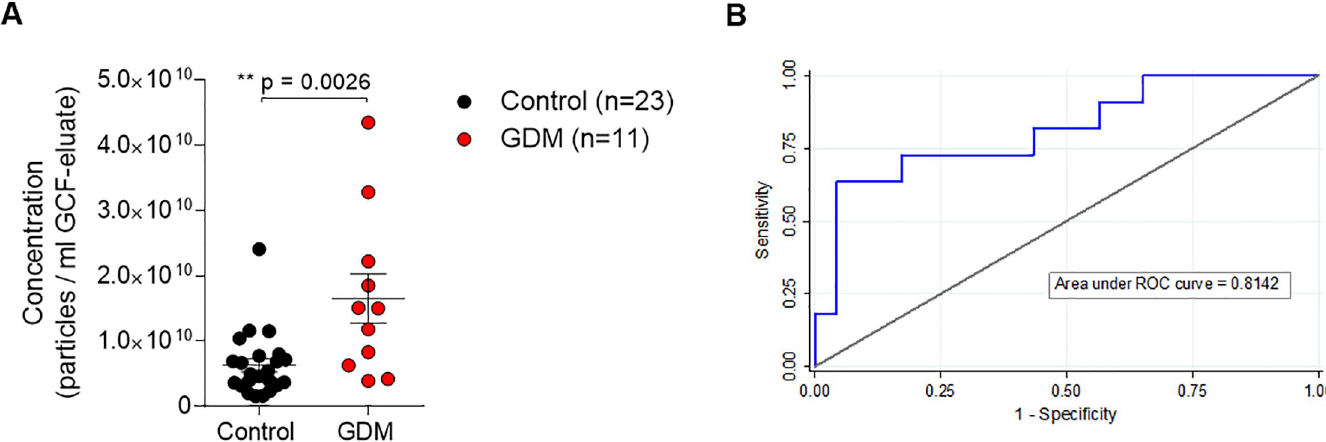
Fig 3. Concentration of EVs isolated from GCF in Controls and GDM patients. A. Mean concentration of total extracellular vesicles present in GCF eluate from Controls (n = 23) and GDM (n = 11). Results are the mean ± SEM. ��� p � 0.001. GDM, gestational diabetes mellitus. B. Receiver Operating Characteristic curve for the prediction of GDM by log 10 EVs concentration in the first trimester (AUC = 0.814). AUC, area under the curve.